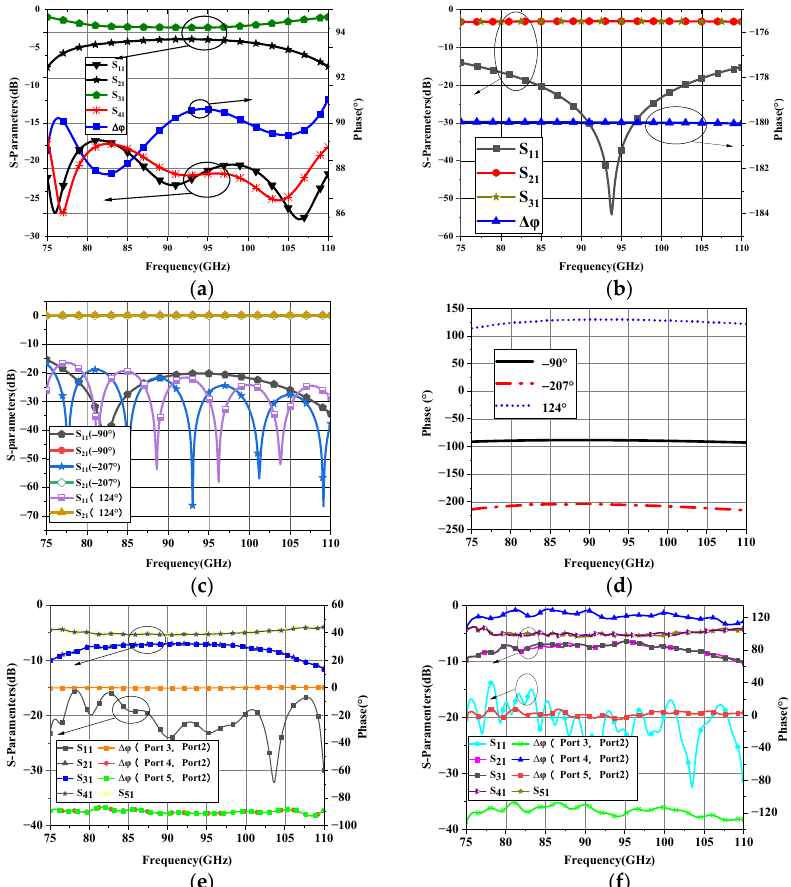
Figure 6. The simulated results of the proposed feed network, ( a ) the simulated s ‐ parameters and phase imbalance of the proposed coupler; ( b ) the simulated s ‐ parameters of the proposed T ‐ junc ‐ tion; ( c ) the simulated s ‐ parameters of the proposed phase shifter; ( d ) the simulated phase deviation of the proposed phase shifter; ( e ) the simulated s ‐ parameters and output phase of the structure in step 1; ( f ) the simulated s ‐ parameters and output phase of the structure in step 2.